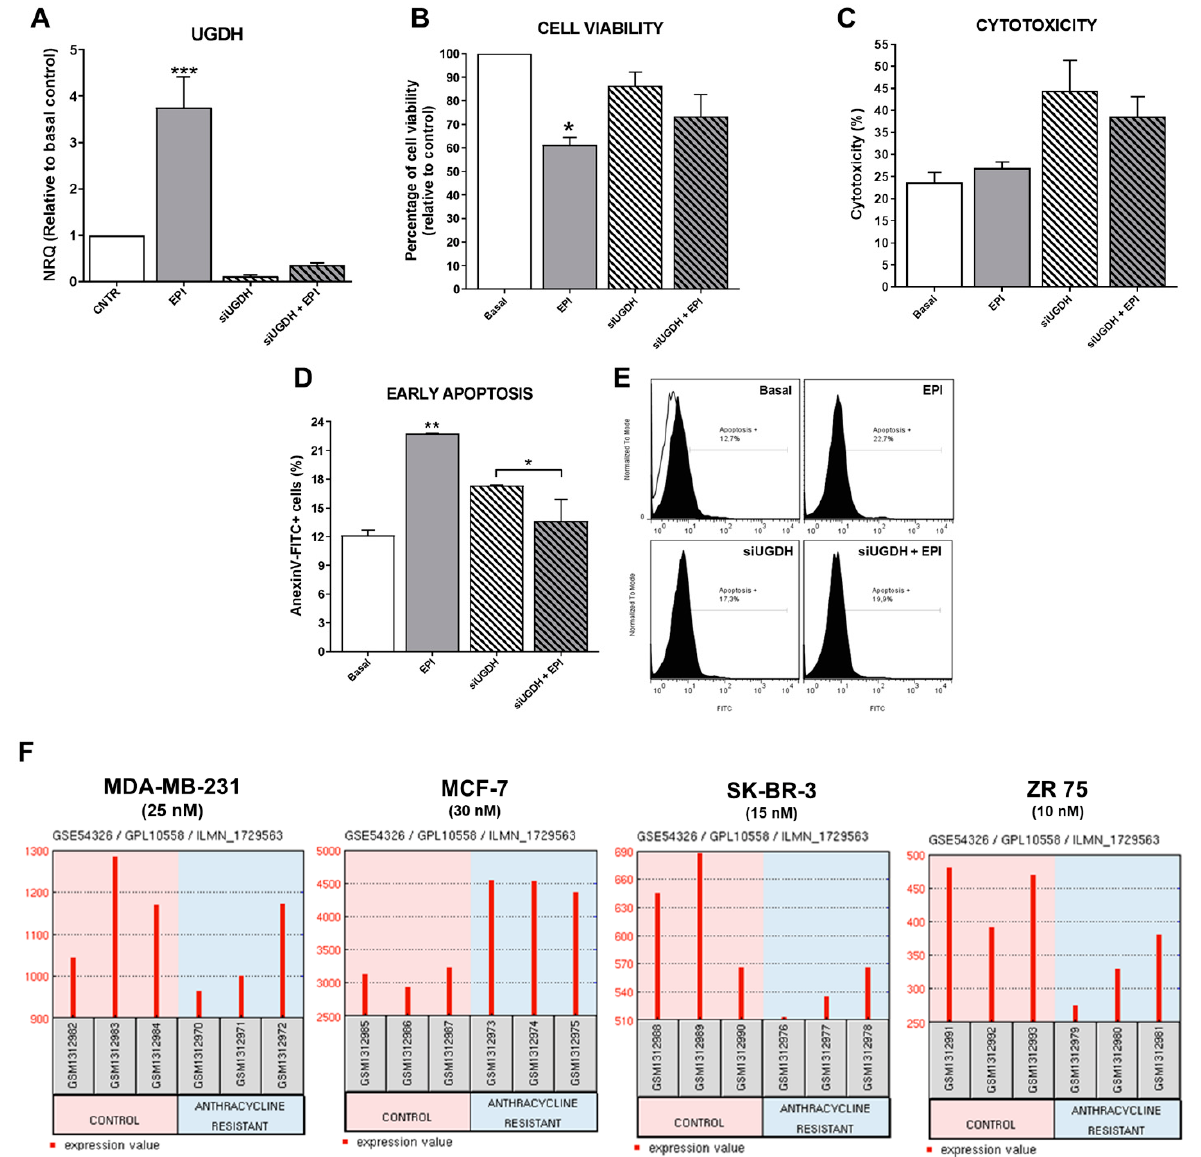
Figure 3. Analysis of MDA-MB-231 cells after silencing of UGDH and EPI treatment. MDA-MB-231 cells were transfected with a specific siRNA against UGDH gene (siUGDH) using a random sequence siRNA as negative control (siSCR). After 24 h, 1 µ M EPI (1 EPI) was added to complete 48 h of incubation. UGDH mRNA levels were obtained by real-time quantitative PCR using Taqman probes ( A ). Cell viability was measured performing a MTT assay ( B ) and cytotoxicity was determined evaluating the activity of lactate dehydrogenase (LDH) enzyme in cell supernatants ( C ). Early apoptosis ( D , E ) was detected by flow cytometry using AnnexinV-FITC stain. Histograms ( E ) show the most representative of three independent experiments performed with 50,000 events/condition. n = 3, mean ± SEM, * p < 0.05, ** p < 0.01, *** p < 0.001. ( F ) Microarray dataset GSE54326 specific for different breast cancer cell lines was used for comparing differential UGDH expression levels in tumor cells resistant to anthracyclines treatment and control cells. In each case, NCBI GEO2R tool was used to analyze UGDH